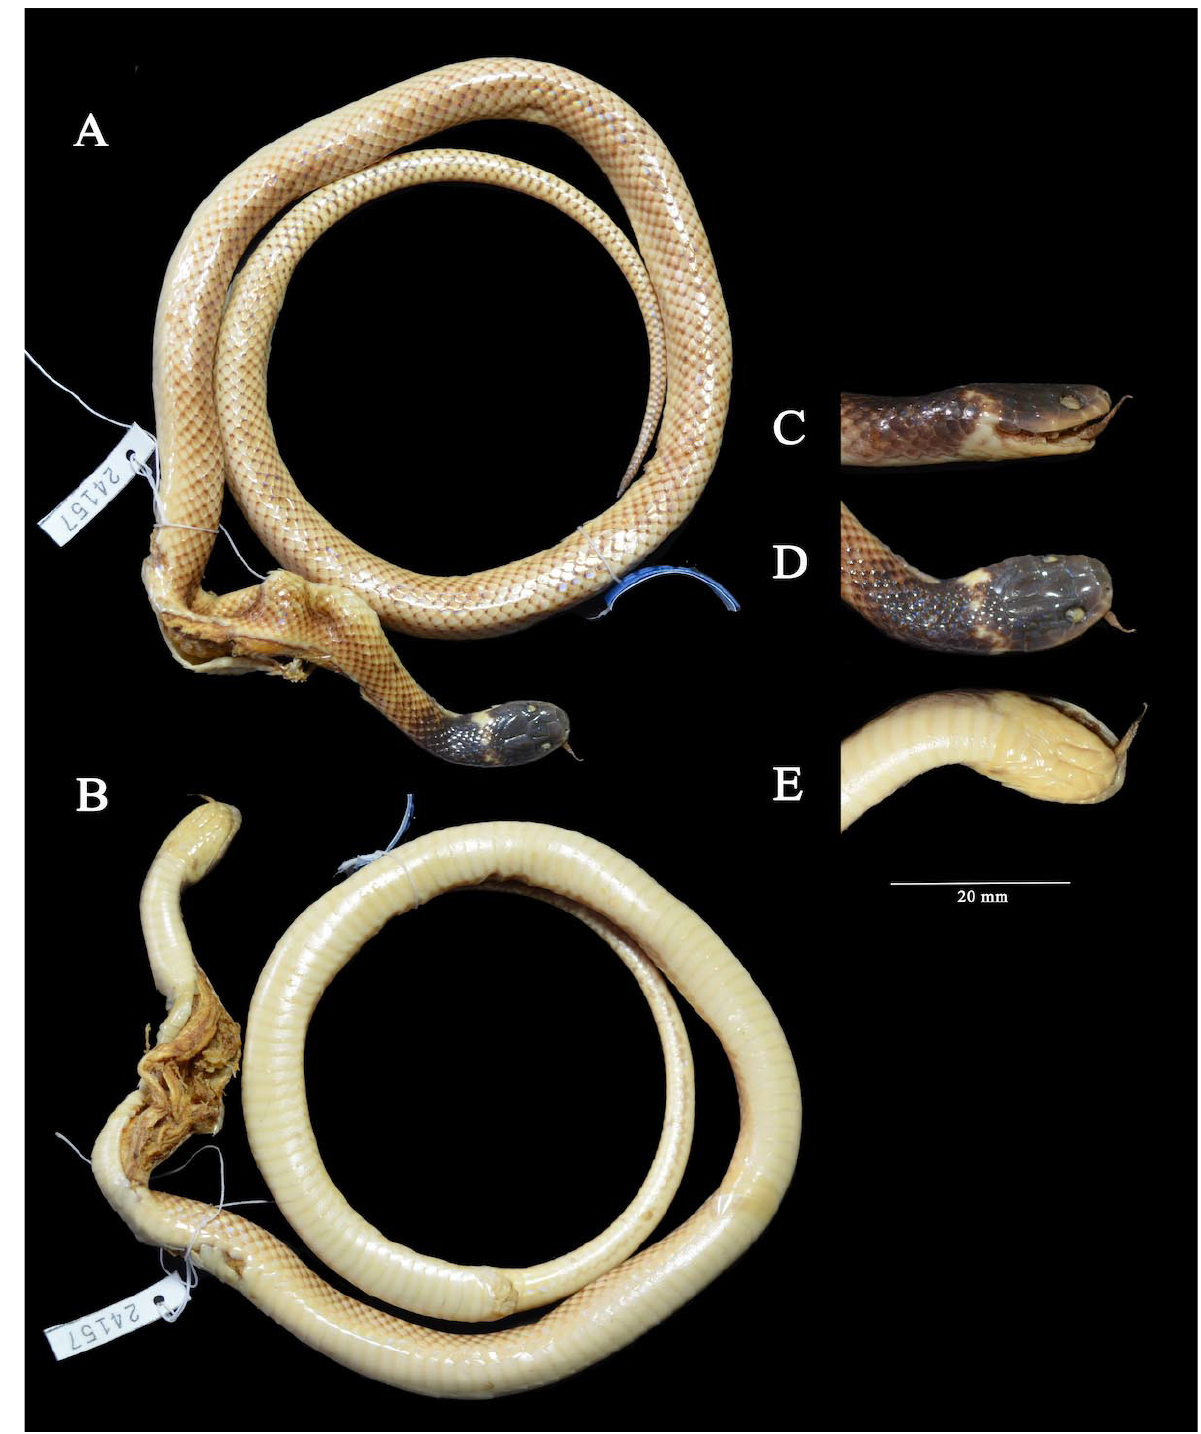
Figure 4. Drepanoides anomalus (MPEG 24157). A . Dorsal view of the body. B . Ventral view of the body. C. Lateral head view. D. Dorsal head view. E. Gular region view. Photographs by